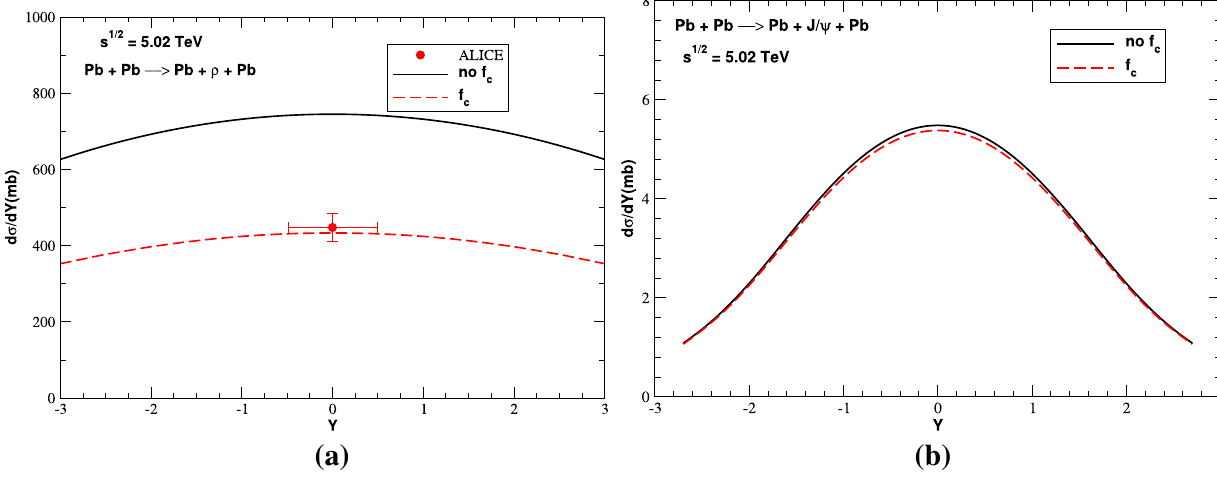
√ s = 5 . 02 TeV. Data from Ref. [62]